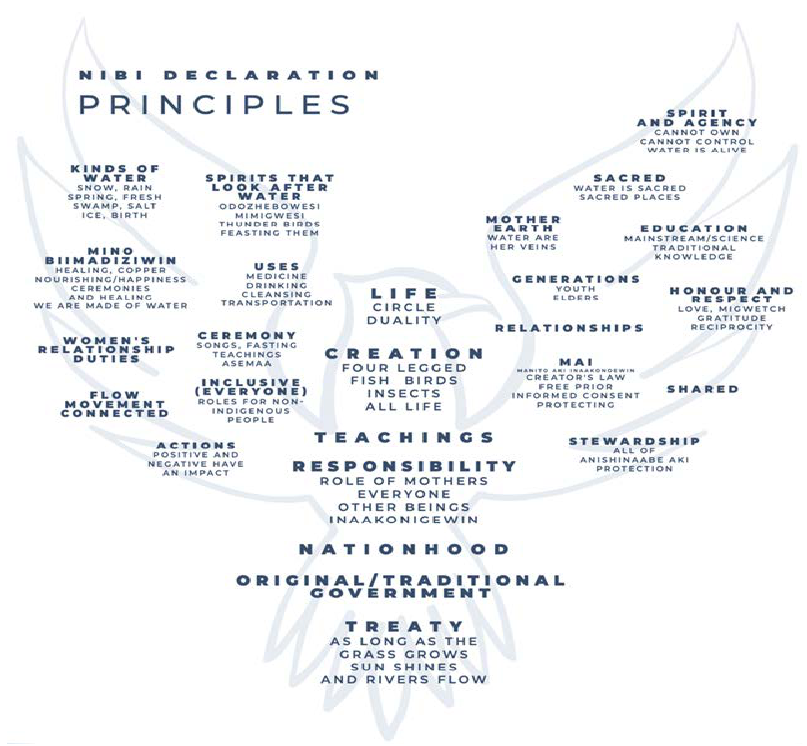
Figure 2. Nibi Declaration Principles [2]. Copyright 2020